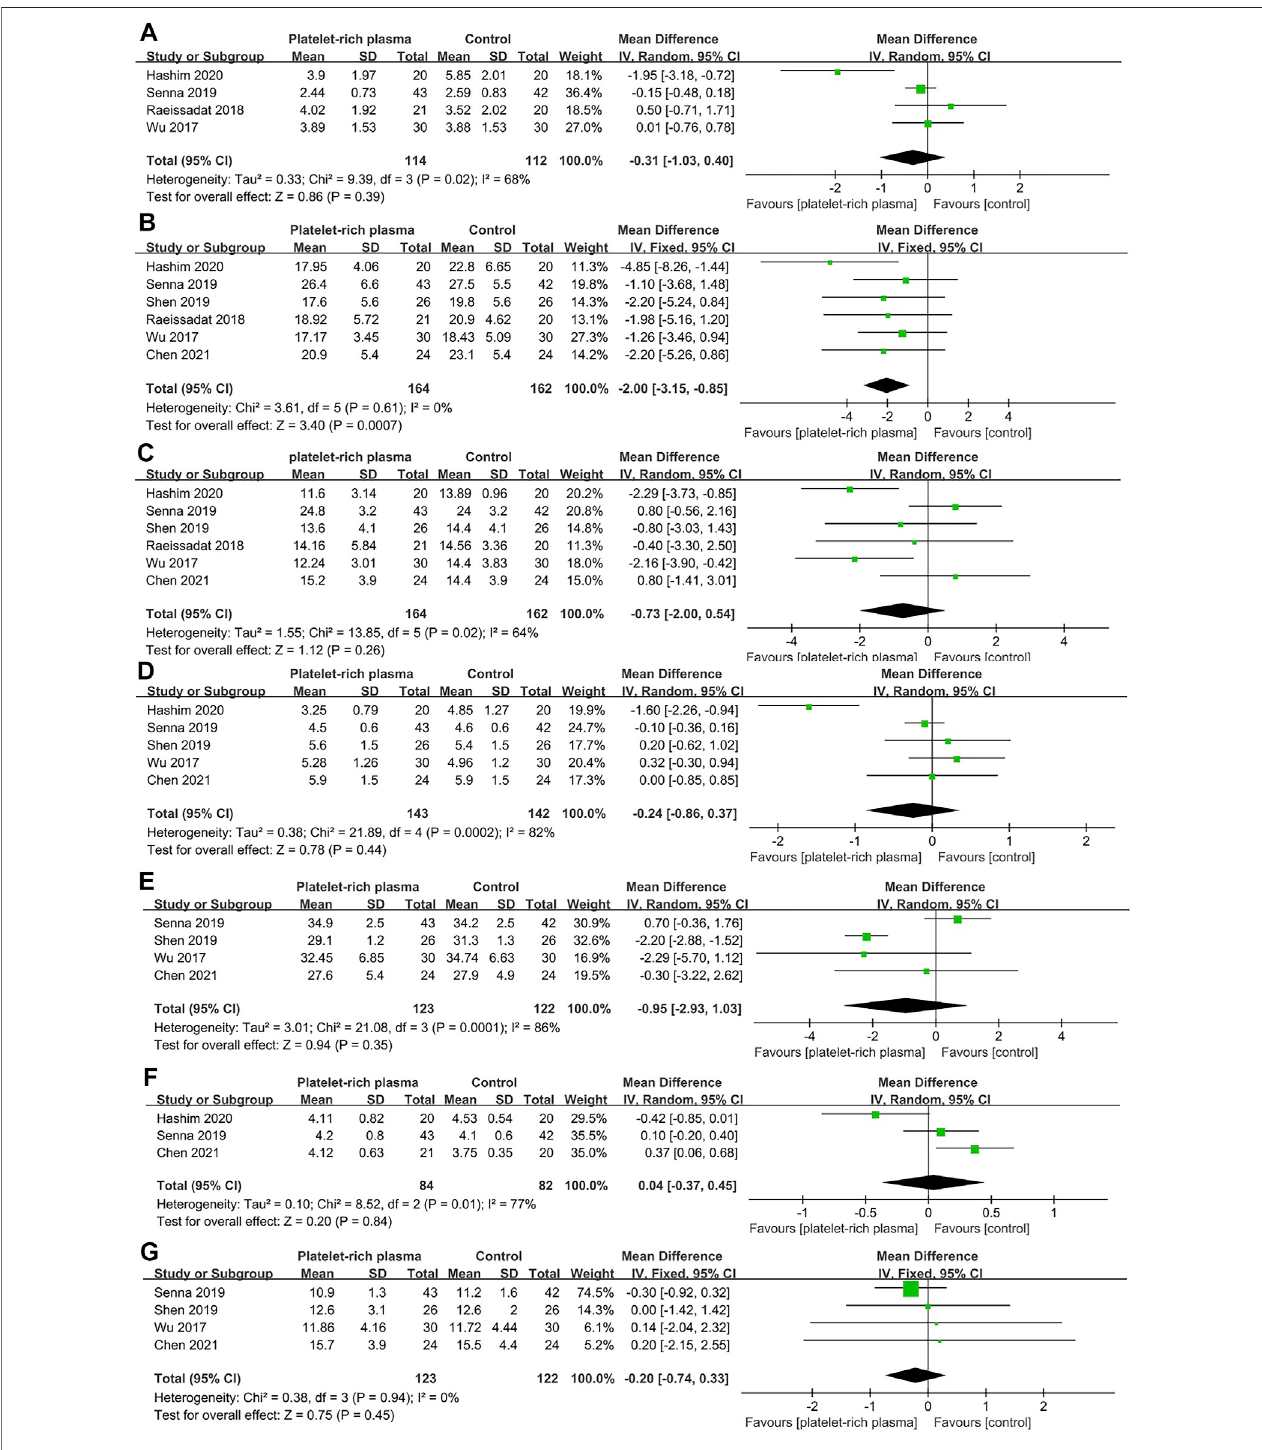
FIGURE 4 | Forest plot showing short-term ef fi cacy of local platelet-rich plasma injection versus other conservative treatments. (A) Visual analogue scale. (B) Symptomseverityscale. (C) Functional status scale. (D) Distal motor latency. (E) Sensory nerveconduction velocity. (F) Sensorypeak latency. (G) Cross sectional area.